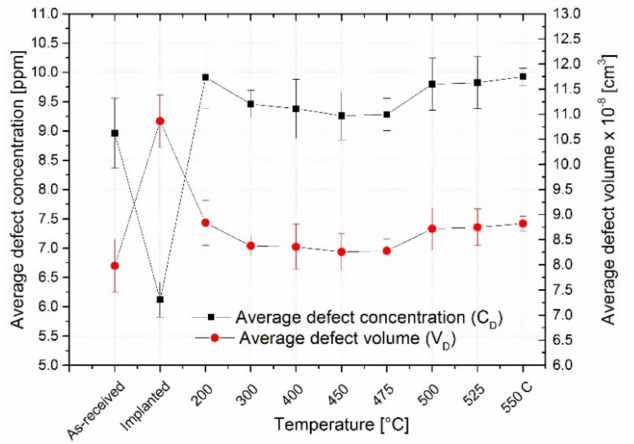
Figure 8. Average values of defect concentration and defect volume for the as-received, implanted, and annealed specimens at 200, 300, 400, 450, 475, 500, 525, and 550 ◦ C. After the implantation, LT 2 increased, with the average value of 188 ± 3 ps represent- ing a mixture of mono-vacancies and di-vacancies with intensity (I 2 ) 42.8 ± 1.6%. The third lifetime appeared with average values of 1 544 ± 820 ps and intensity of 0.4 ± 0.1%.